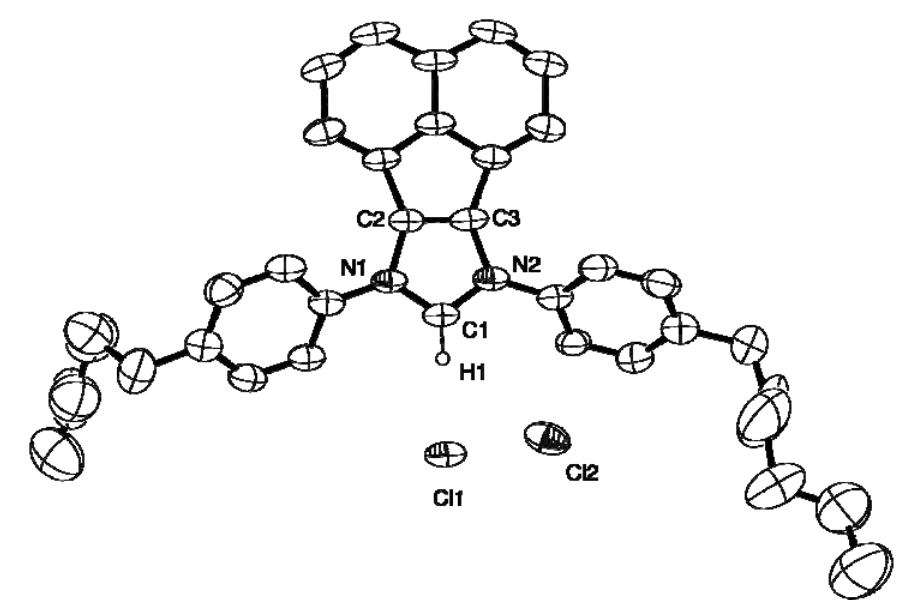
Figure 5. ORTEP diagram of 5 with 40% probability thermal ellipsoids. Hydrogen atoms except H1 are omitted for clarity. The hydrogen atom of the anion [HCl in the difference map.